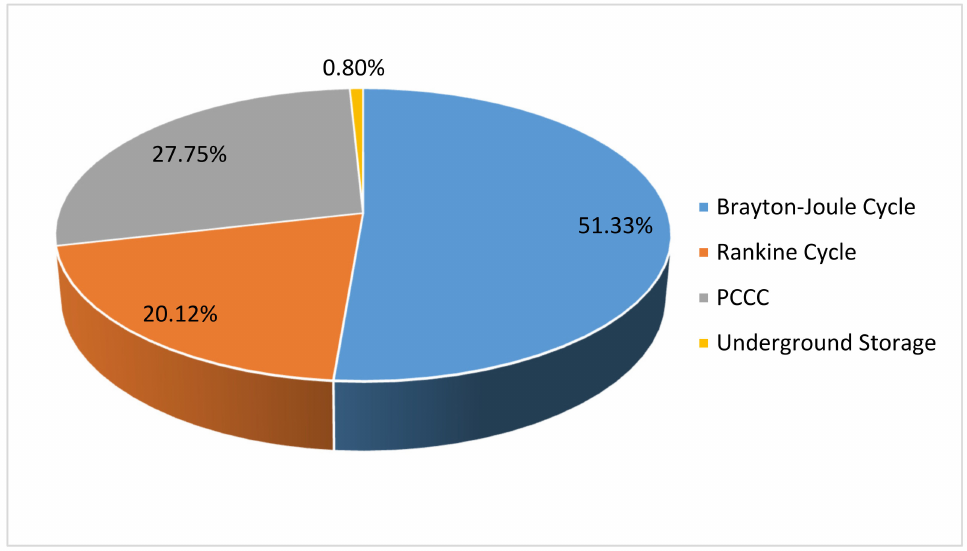
Figure 11. Distribution of exergy destruction between the units (total E D = 541.42